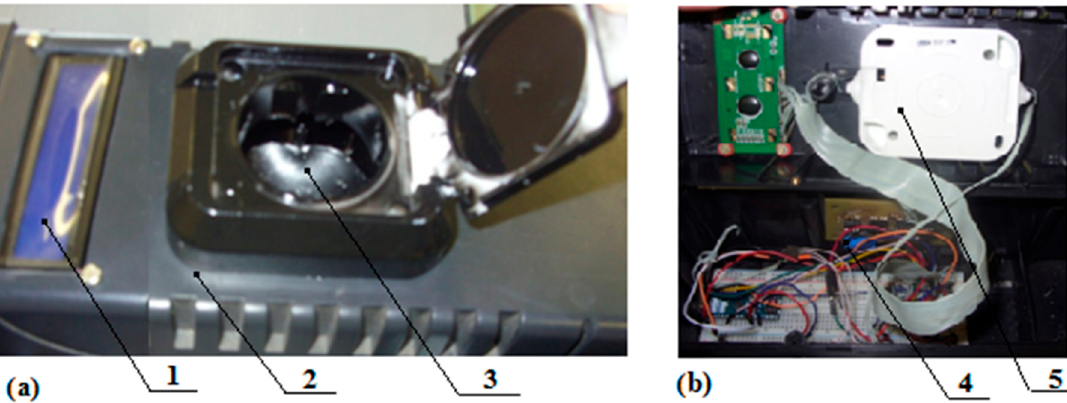
Figure 6. Exterior ( a ) and interior ( b ) layout of the device: 1—display; 2—housing; 3—seed chamber; 4—electronic unit; 5—light source and receiver unit.